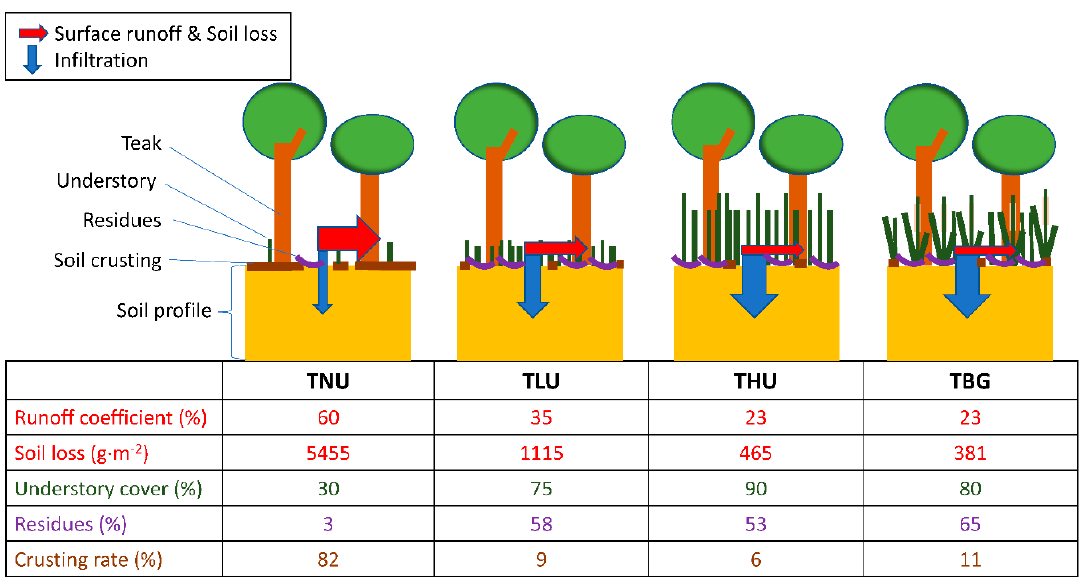
Figure 10. Graphical abstract. TNU: teak with no understory; TLU: teak with low density of understory; THU: teak with high density of understory; TBG: teak with broom grass.